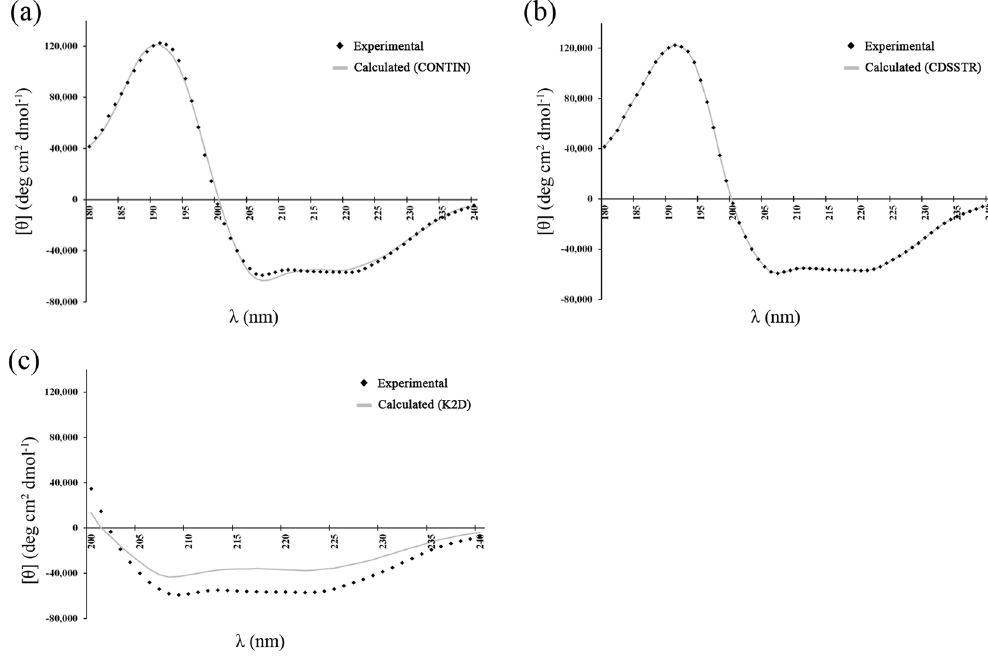
Figure 1. CD spectra of r Pm VRP15 analysed by CONTINLL ( a ), CDSSTR ( b ) and K2D ( c ) algorithms via DichroWeb. SMP180 was used as reference dataset. CDSSTR (the best fit) gave calculated secondary structure of 82% α -helix, 4% β -strand, 8% turn and 6%